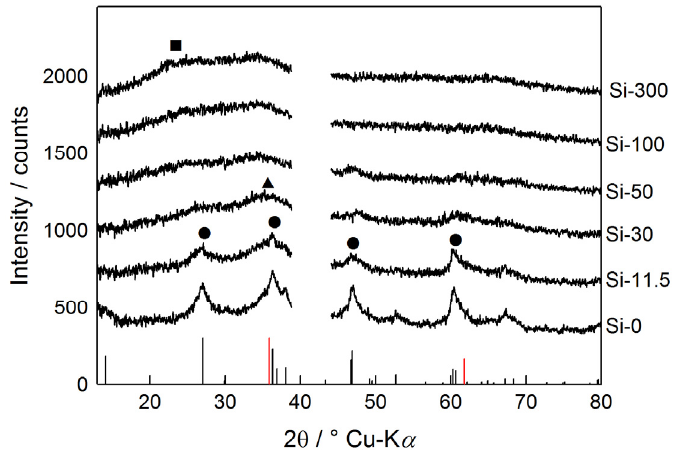
Figure 4. X-ray diffractometery (XRD) patterns of cultured sheaths in media with different Si contents. ( a ) Si-0, ( b ) Si-11.5, ( c ) Si-30, ( d ) Si-50, ( e ) Si-100, and ( f ) Si-300. The positions of the diffraction peaks were assigned using the ICDD database. The main diffraction peak for lepidocrocite (black circle), 2Fh (black triangle), and XRD-amorphous silica (black square) is indicated. The position of the diffraction peaks in ICDD database of lepidocrocite (PDF 00-044-1415) and in reference 16 of 2Fh are given as black and red bars in the bottom of the figure, respectively. The break near 40° corresponds to the peaks derived from the sample